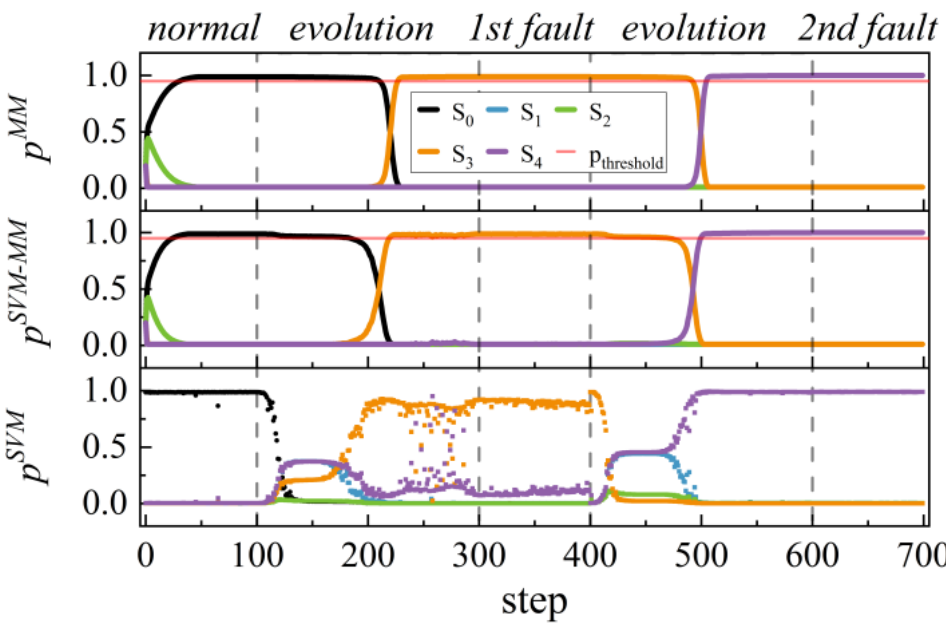
Figure 8. Diagnosis results for multiple faults: S 3 and S 4 Table 4. Multiple-Fault Diagnosis Performance Indicators.